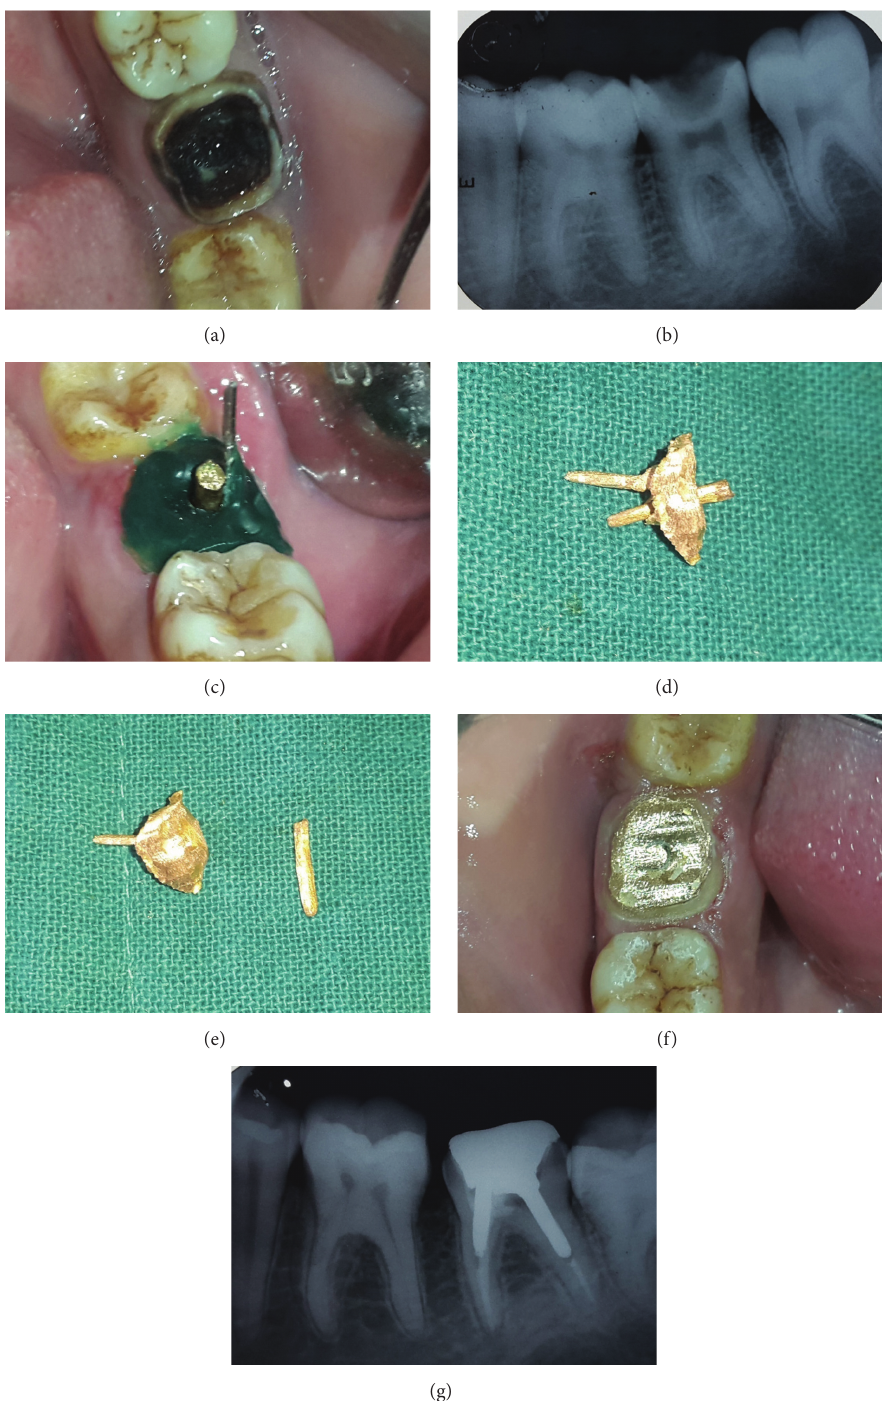
Figure 2: (a) Preoperative intraoral photograph showing grossly decayed molar. (b) Preoperative IOPAR showing grossly decayed molar with divergent root configuration. (c) Wax pattern fabrication of mesiolingual canal and core with distal casting in place. (d) Assembly of mesial and distal sections of split cast post and core. (e) Mesial and distal sections of split post and core. (f) Luted and finished split cast post and core. (g) IOPAR of luted and finished split cast post and